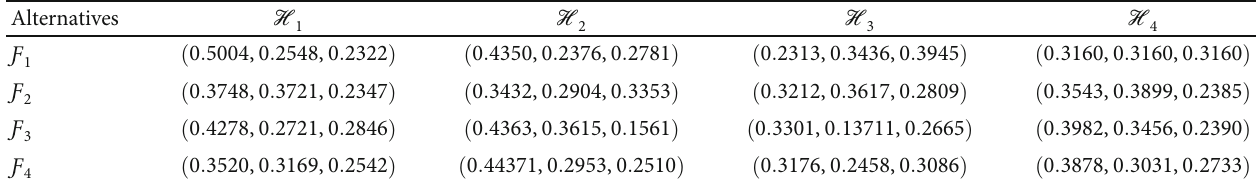
Table 3: Aggregated values of the experts by the PFWNA